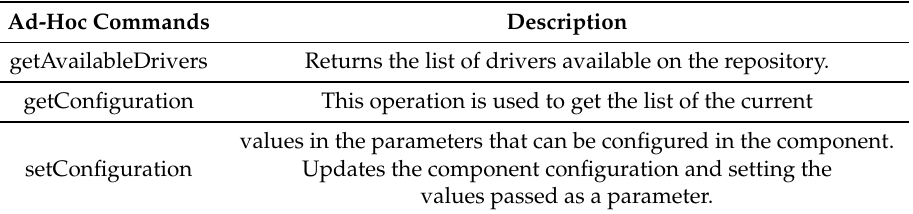
Table 2. Configuration Management Ad-Hoc